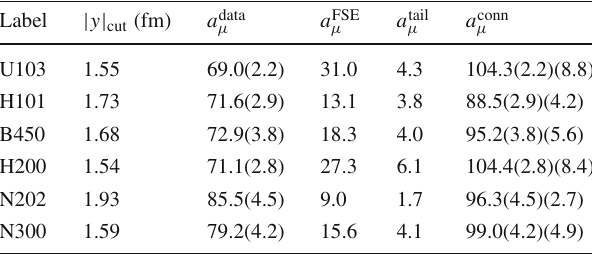
Fig. 9 Study of FSEs for method 1. Left: integrand for the ensembles H200 and N202 with m π L = 4 . 4 and 6.4 respectively. Right: value of a conn μ for the ensemble N202 using the FSE correction prescription described in the text, as a function of | y | cut Table 5 Results for the connected contribution using method 1 with four local vector currents using the decomposition given by Eq. (20). A 25% systematic to the total correction is